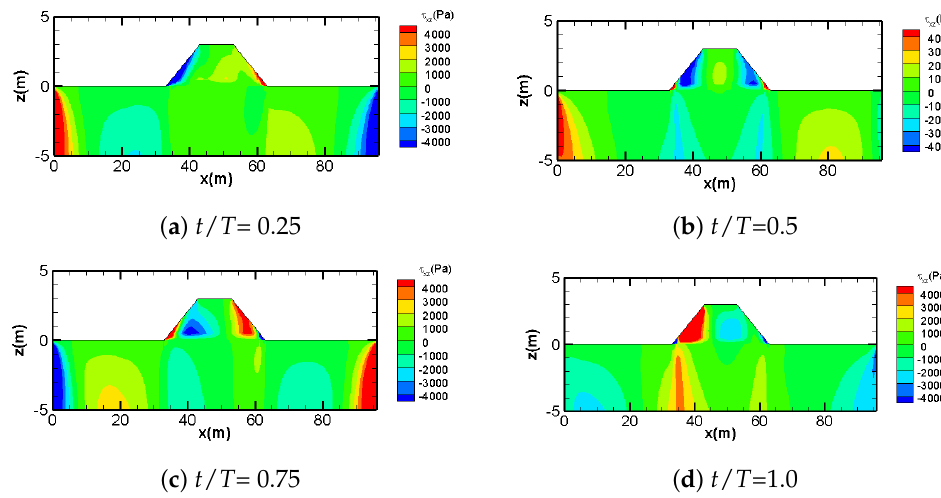
Figure 7. Distribution of the wave-induced shear stress in the vicinity of the breakwater.